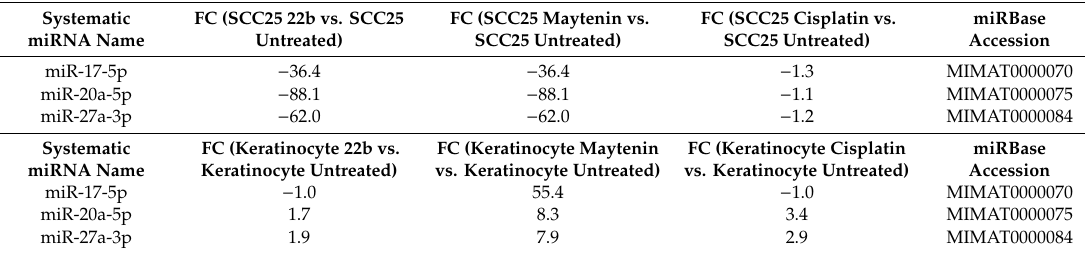
Table 2. Fold changes in miR-27a and miR-20a / miR-17-5p expression in treated cells. Cells were treated with cisplatin, maytenin or 22- β -hydroxymaytenin at IC 50 for 24 h and compared with untreated cells. miRBAse: http: // www.mirbase.org /